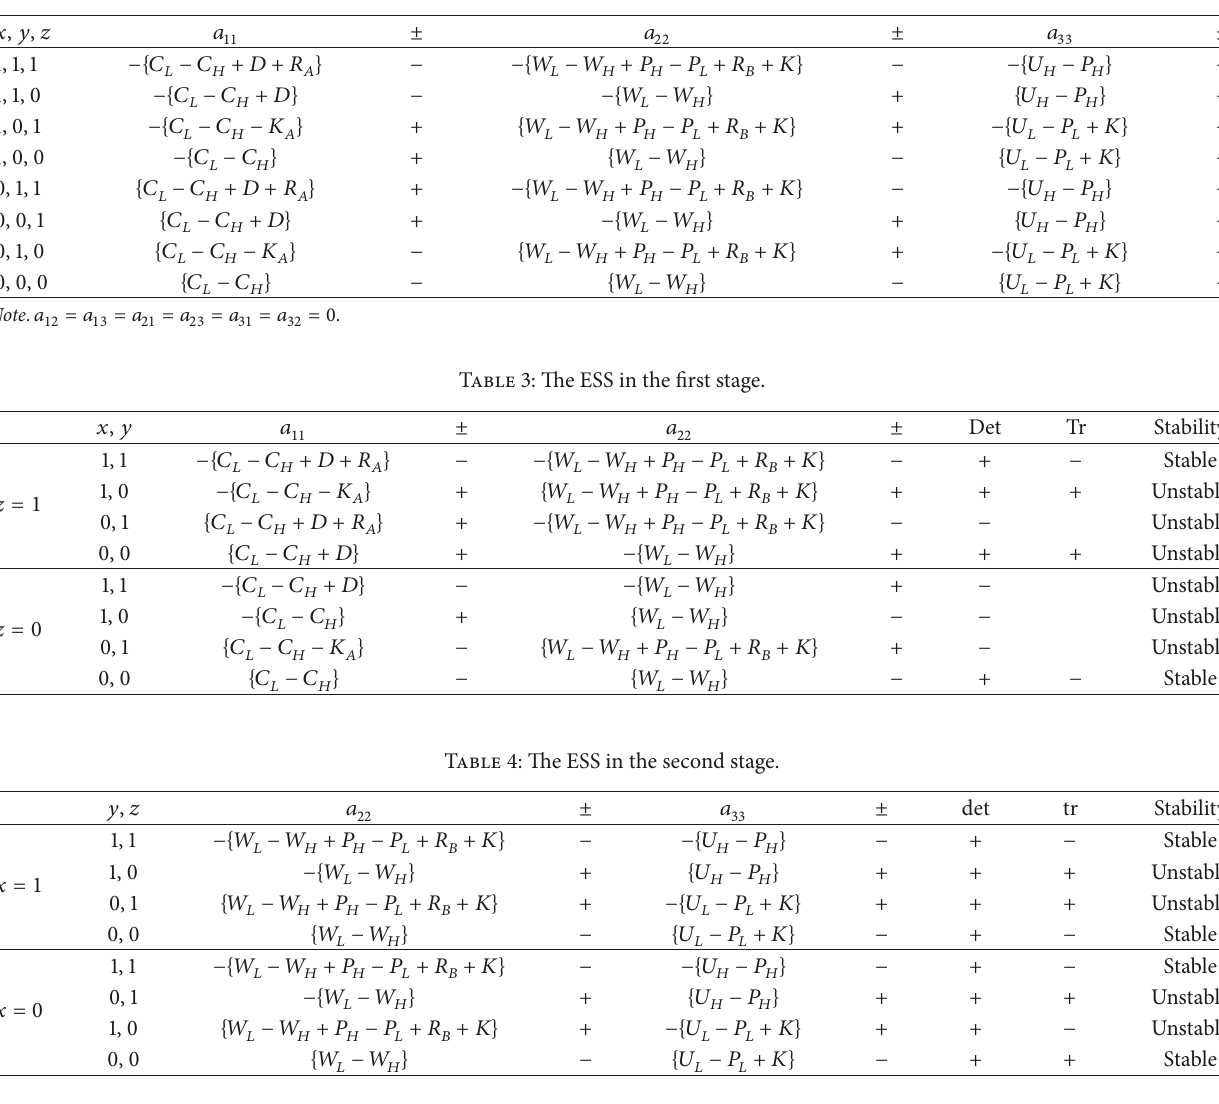
Table 2: Main eigenvalues of Jacobian matrix.